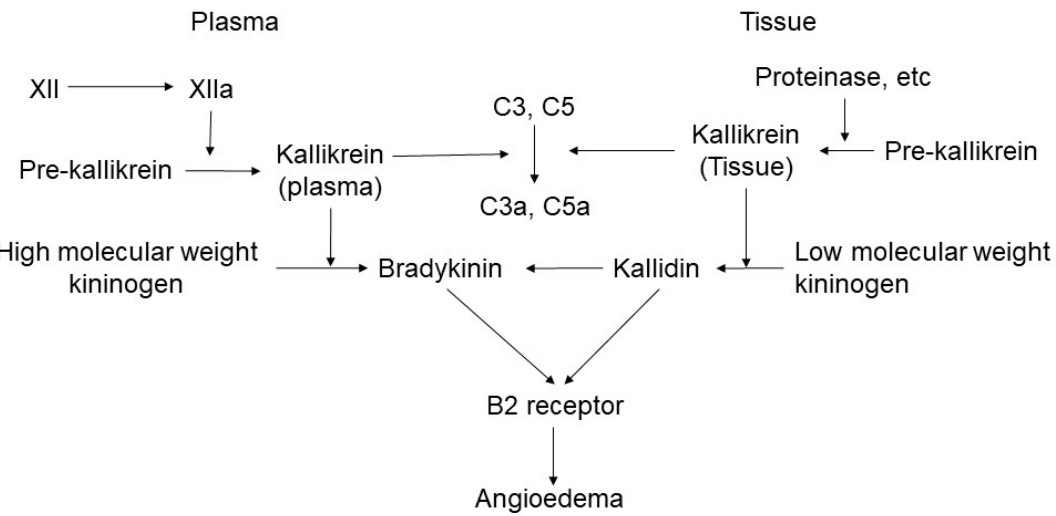
Figure 1. Cascade of bradykinin-mediated angioedema. Bradykinin is produced in the process of activating the kinin– kallikrein system and vascular-coagulation system cascade.